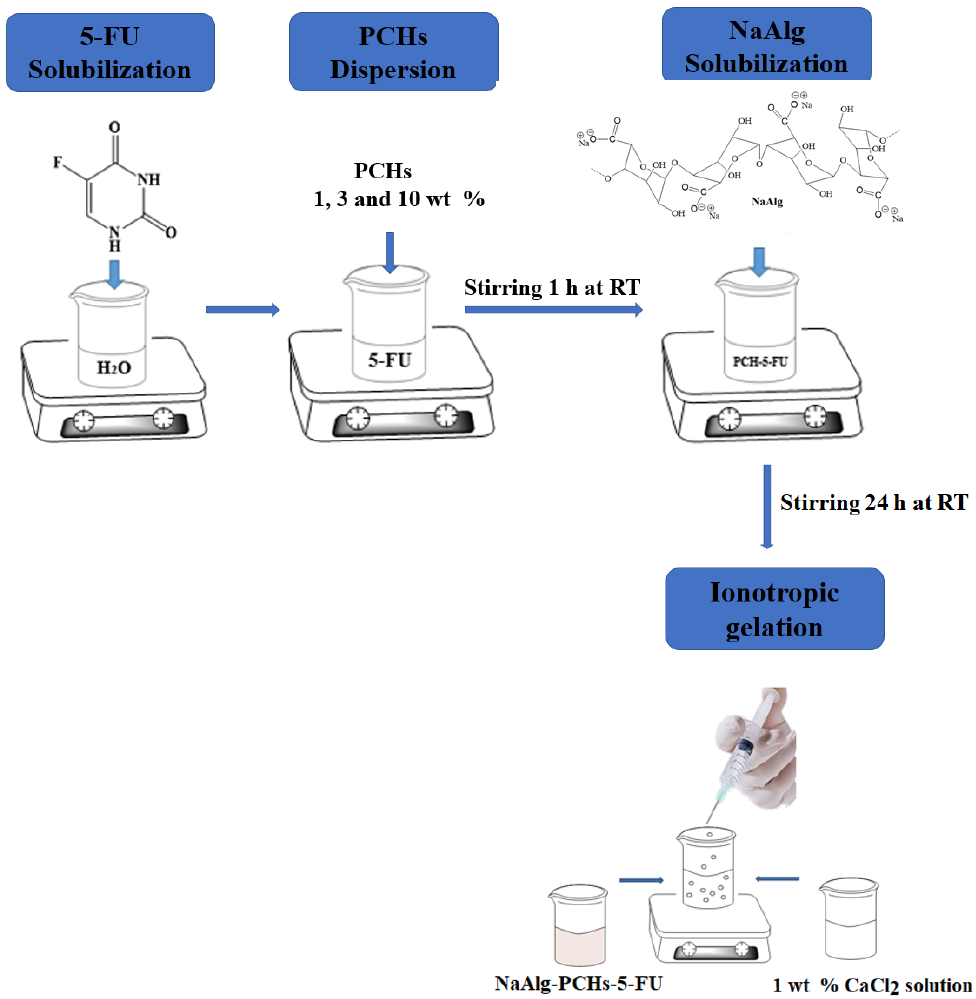
Figure 2. Synthesis steps of hybrid beads.